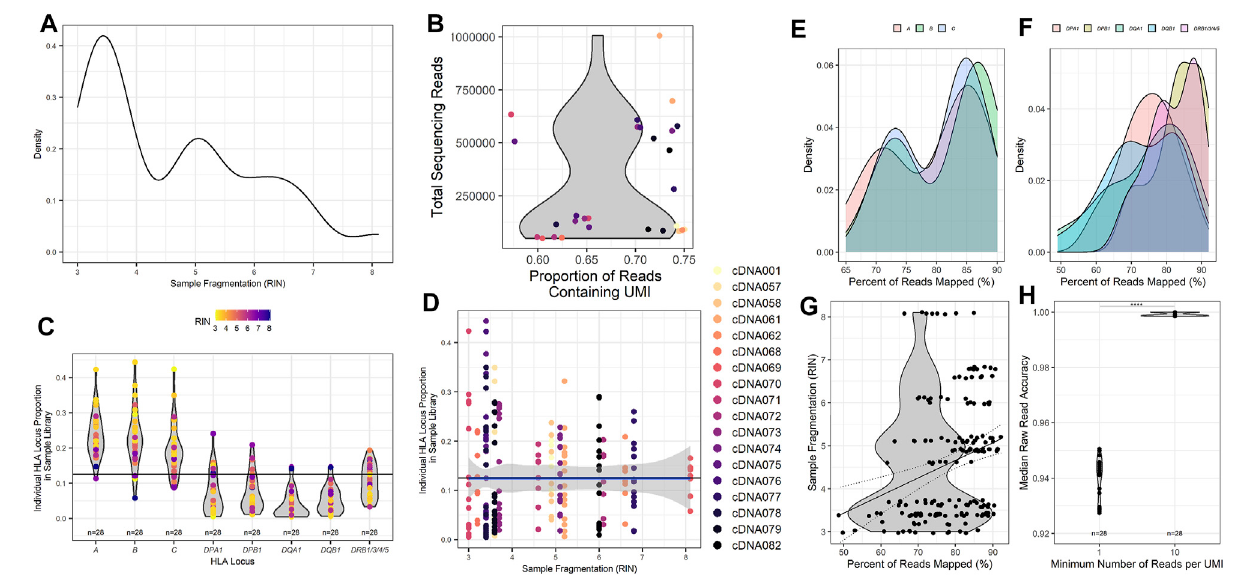
FIGURE 2 | Metrics for HLA typing using unique molecular identi fi er-tagged RNA demonstrates that as fragmentation decreases, more reads are obtained for sequencing,and agreaterproportion ofreads canbe mapped toHLAloci ofinterest. (A) Calculated RNAintegrity numbers for each patient samplewiththeir measured band density post isolation and clean-up. (B) Sample sequencing reads acquired and the proportion of the reads that contain recognized UMI barcodes. (C) The proportion of reads per classical HLA locus per patient sample as counted using UMI reads. (D) The proportion of reads for each HLA locus compared to the calculatedRNAintegritynumberforeachpatientsample. (E) ThepercentageofcDNAreadsobtainedthatcouldbemappedtotheHLAlociobtainedduringsequencing and their respective calculated sample RNA integrity numbers. (F) Read accuracy calculated for the minimum number of UMIs required for each HLA locus and sample after concatenation ofcDNAreads toconsensus sequences. The percentage of (G) class I and (H) class IIHLA-speci fi creads mapped compared toinput isolated RNA measured band density (**** p value < 0.001).